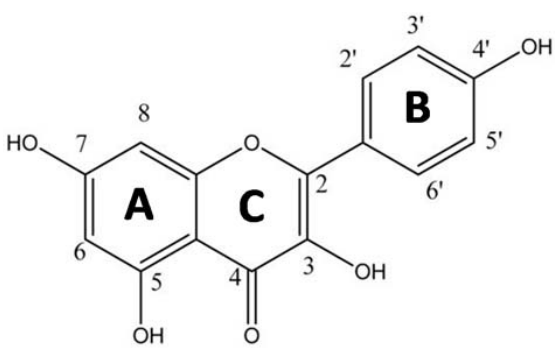
Figure 1. Structure of kaempferol.